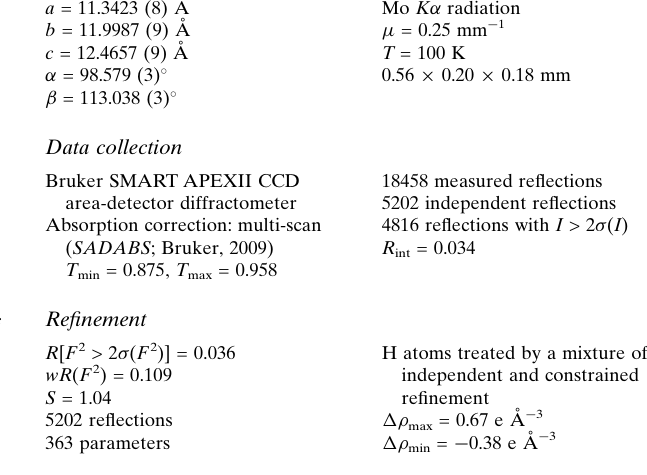
and exists in a keto form, the C O bond lengths being